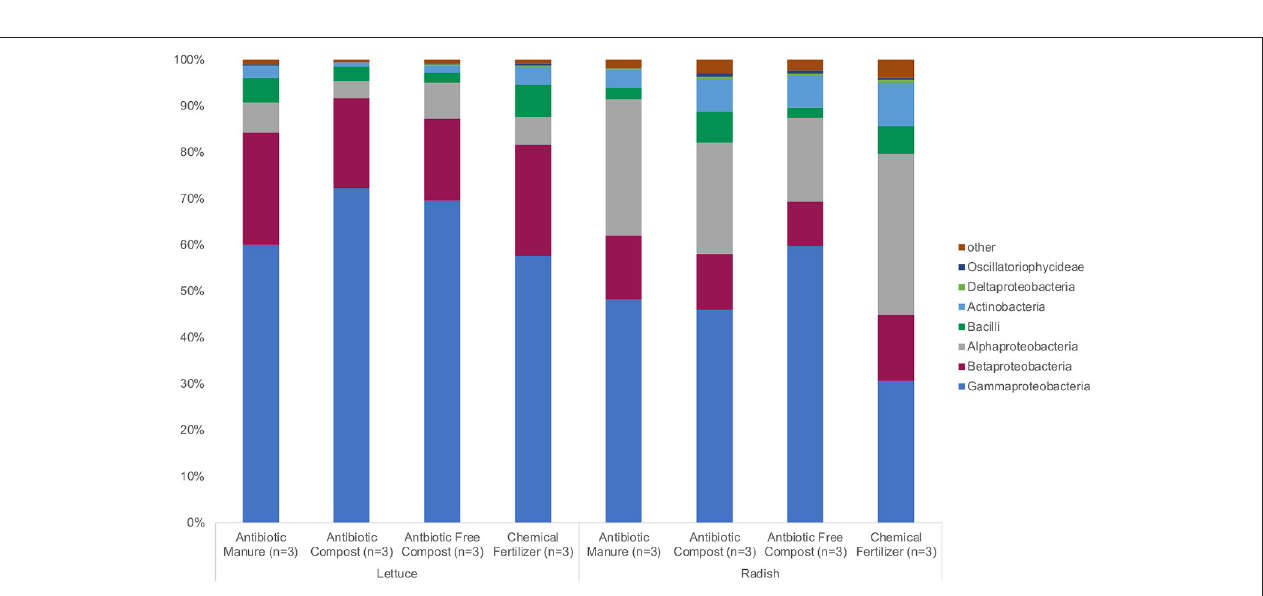
FIGURE 1 | NMDS analysis of Unweighted Unifrac distance matrix of the bacterial microbiota represented by 16S rRNA gene amplicon sequences recovered from field-grown lettuce and radish samples. Each point indicates vegetables harvested from separate replicated plots described in Supplemental Figure S1 . ANOSIM indicated that samples were significantly different based on vegetable type ( p < 0.001) and amendment type ( p = 0.02). Samples were strongly separated based on vegetable type (Global R = 0.77).